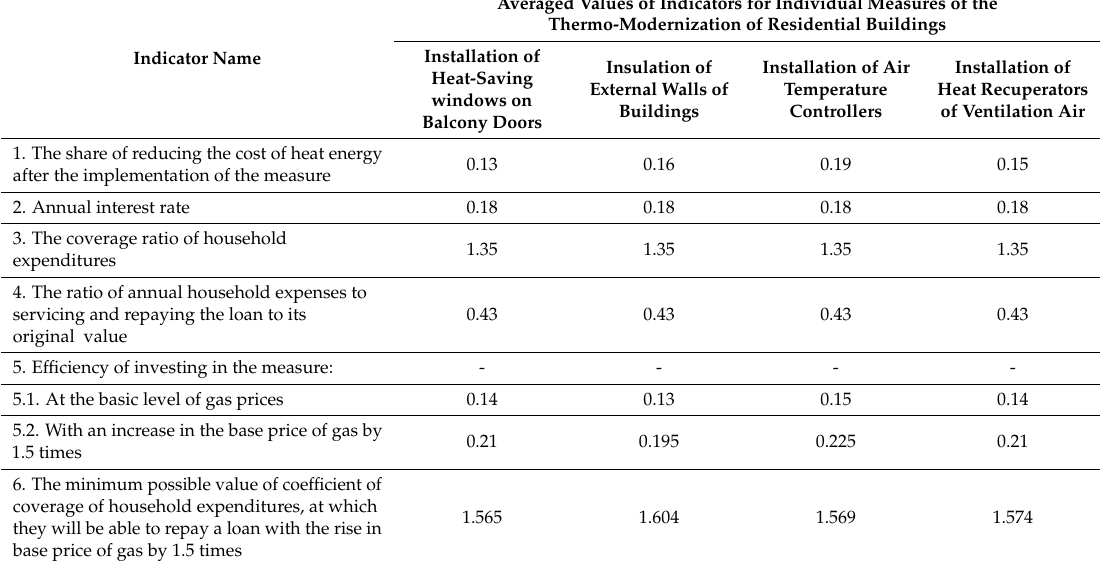
Table 9. Averaged values of the indicators characterizing individual measures of thermo-modernization of residential buildings in